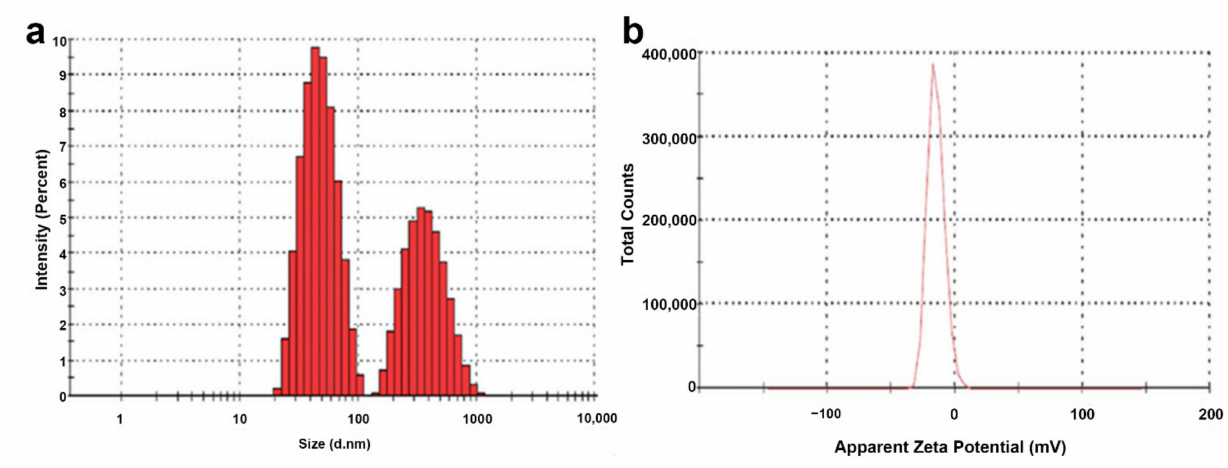
Figure 4. ( a ) Zeta size measurement and ( b ) Zeta potential measurement of MgO-NPs.